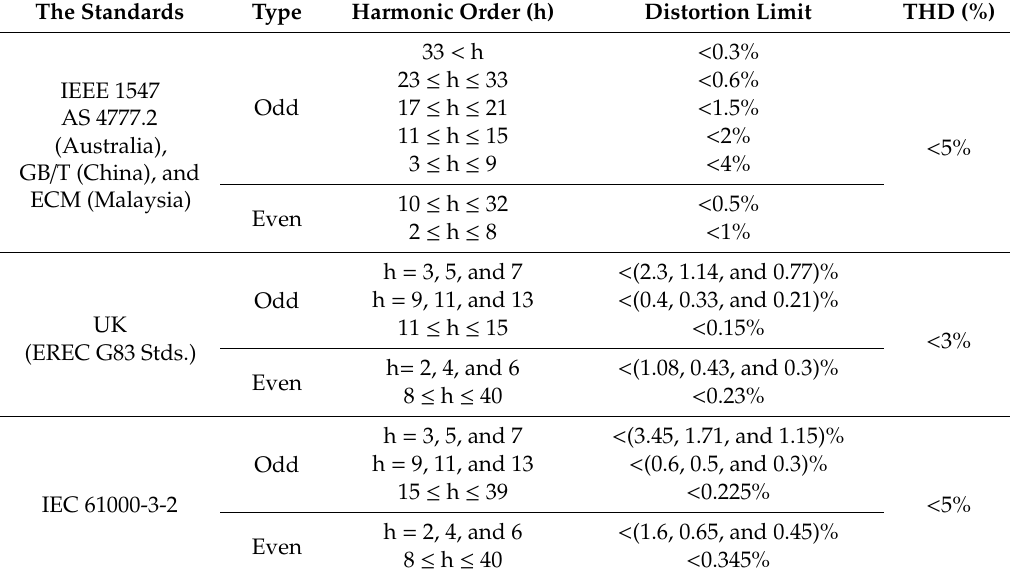
Table 2. Current harmonics distortion limits of the PV